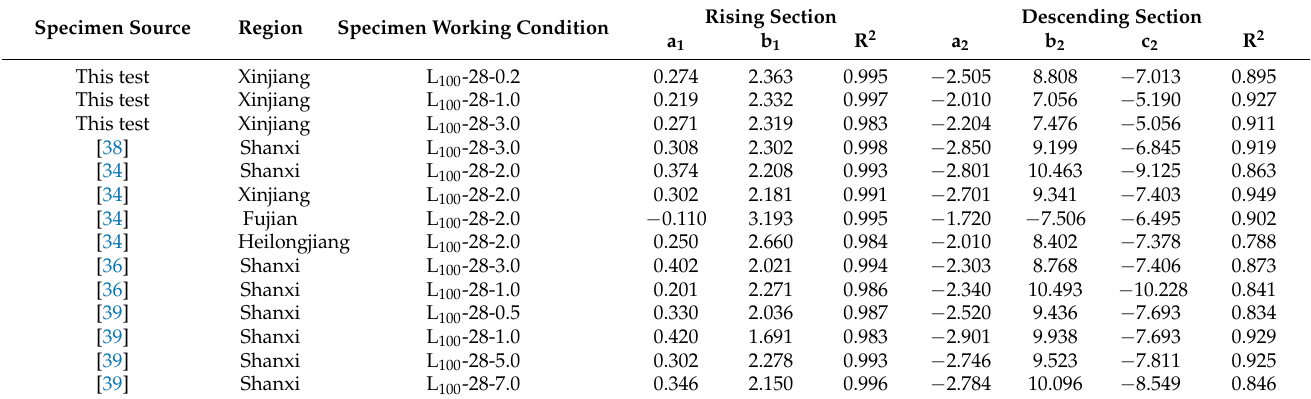
Table 7. Fitting parameters of constitutive equation of different earth specimens.